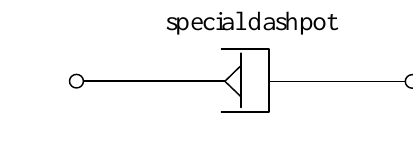
Figure 4: Mechanical analogy diagram of Model